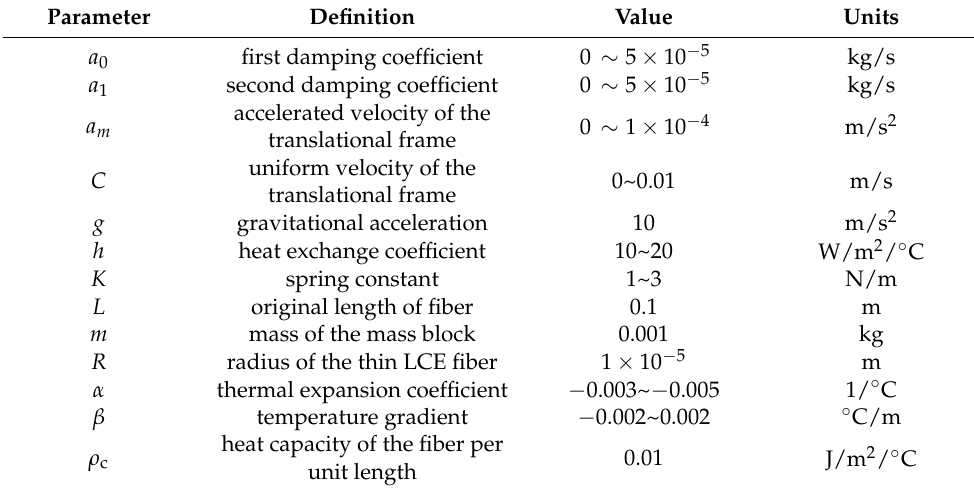
Table 1. Material properties and geometric parameters.